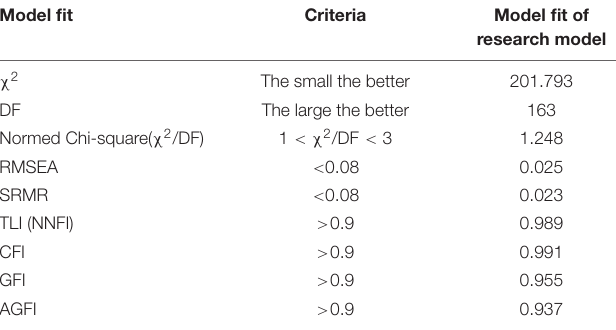
TABLE 8 | The analysis of moderating